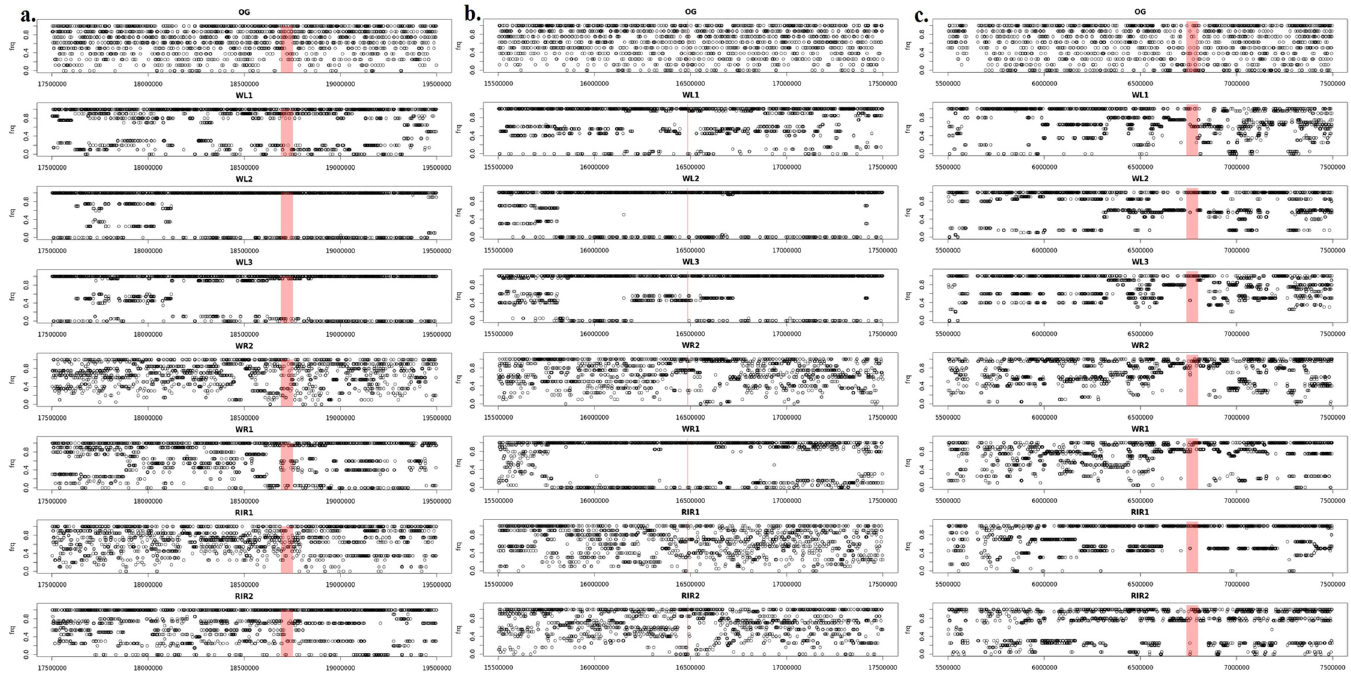
Fig 5. Allele frequency in different breeds for 2 Mbp around the intended region. Red box indicates, for (A) TGFB2 gene (Chr3: 18,690,003 – 18,753,123), (B) H3F3C gene (Chr3: 16,483,162 – 16,487,393) and (C) 60Kb region on chromosome 10 (6,799,776 – 6,738,610).